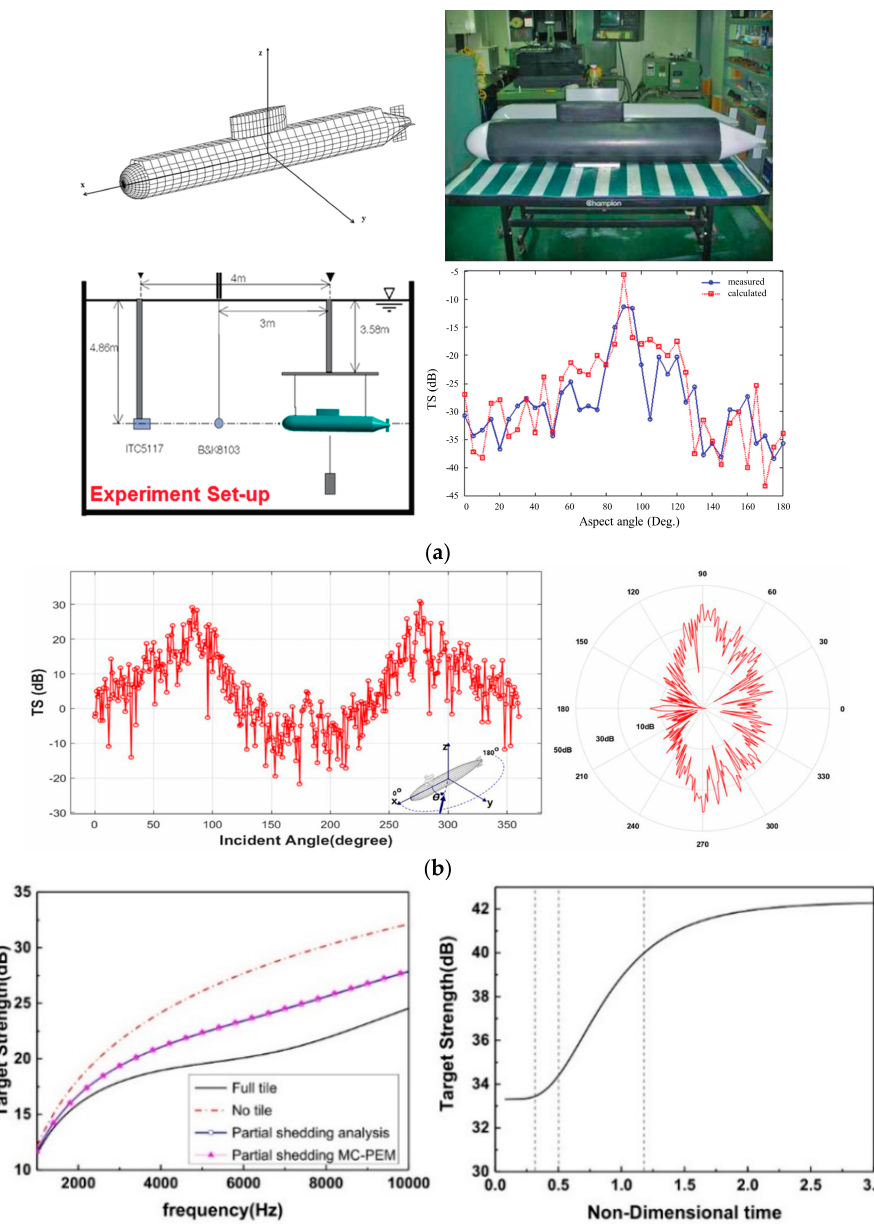
Figure 11. Research on target strength characteristics of the submarine. ( a ) Mesh model, test model, experiment equipment, and comparison of experimental and numerical solutions for target strength (TS) [48]. ( b ) TS of the rectangular and polar coordinate of the submarine model at a frequency of 5 kHz and a distance of 500 m [49]. ( c ) Comparison of the analytical method and Monte Carlo–Plate Element Method (MC-PEM) and the relationship between TS and non-dimensioned time [50].